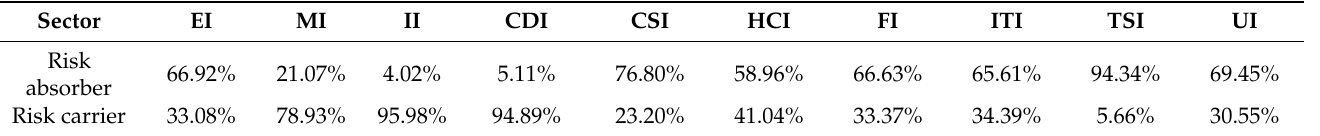
Table 5. Statistics on the proportion of roles undertaken by 10 sectors during the sample period.